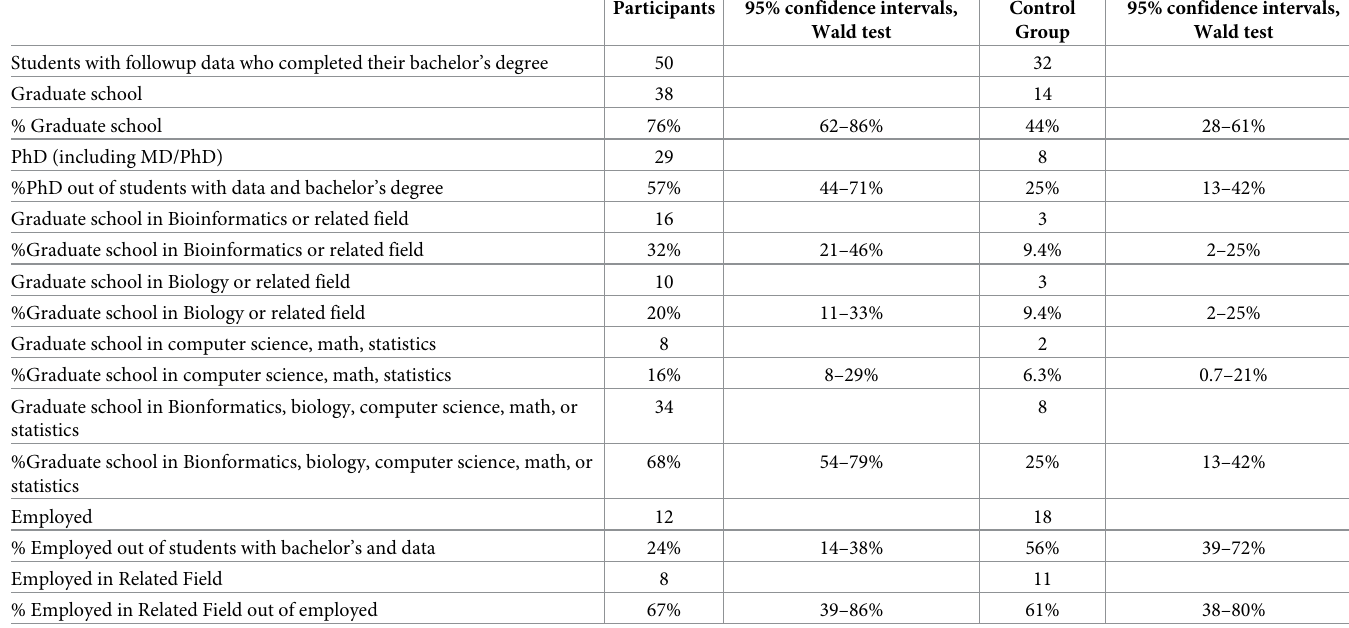
to attend. The GPA’s for the participant (3.6) and control (3.7) groups were not statistically sig- nificantly different based on Student’s t-test. The fraction that are women (41/72 or 57% for the control group, 60/111 or 54% for the participant group) is not significantly different by chi-square analysis. The fraction that are URM students (19/72 or 26% for the control group, 38/111 or 34% for the participant group) is not significantly different by chi-square test (Table 2). Among the students in the control group, 26% were in the 2016 cohort, 34% were in the 2017 cohort, and 40% were in the 2018 cohort. Among students in the participant group, 29% were in the 2016 cohort, 32% were in the 2017 cohort, and 39% were in the 2018 cohort. The fraction of students in the control and participant groups in different BIG Summer cohorts is not significantly different by chi-square test. Most of the participating students were rising seniors or rising juniors (Table 3). The distribution of year in college for the control and participant students is not significantly different by chi-square